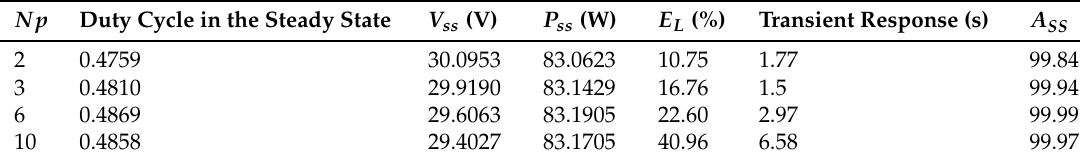
Table 5. Comparison performances under different Np